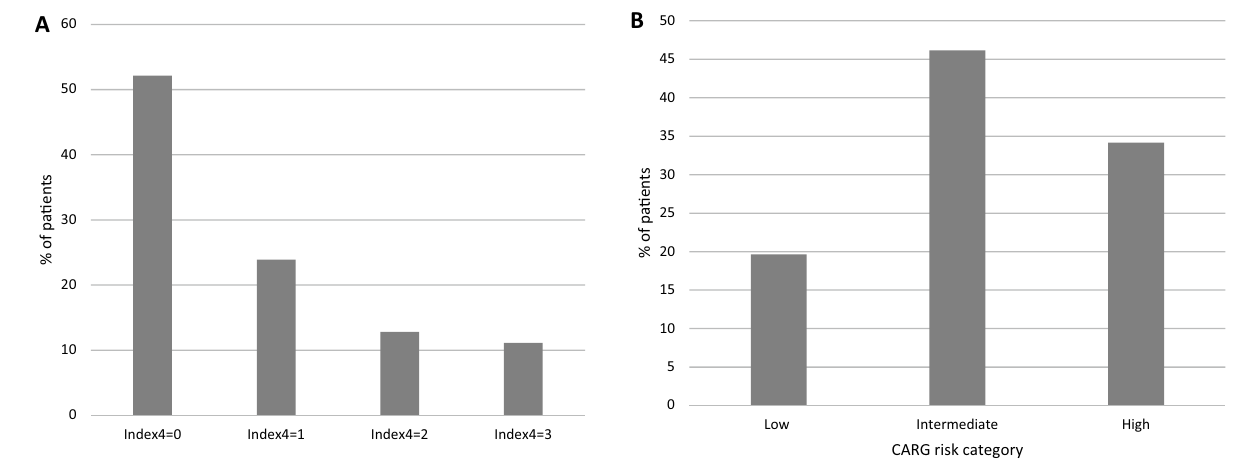
Figure 1. ( A ) Distribution of Index4 scores and ( B ) distribution of CARG risk categories in the cohort of patients included in the study.